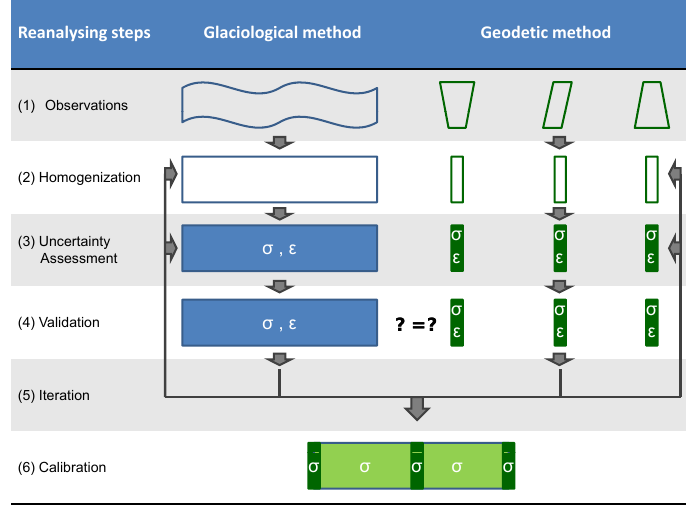
Fig. 1. Generic scheme for reanalysing glacier mass balance series in six steps, as described in Sects. 3.1–3.6. A series of N annual glacio- logical observations and three multi-annual geodetic surveys are independently homogenized and assessed for systematic ( ε) and random ( σ) errors. Resulting glaciological balances are validated and calibrated (if necessary) against geodetic balances in order to reduce unexplained differences identified as significant according to common confidence